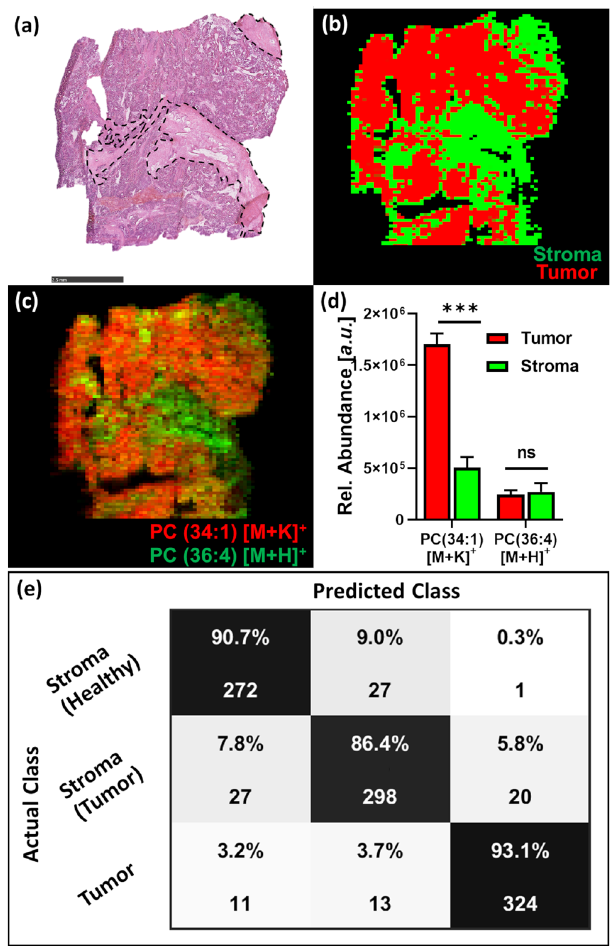
Figure 5. ( a ) Post-DESI-MSI H&E-stained tissue section of the ovarian tumor sample, scale bar = 2.5 mm. ( b ) MMC segmentation into tumor (red) and stroma (green), unclassified pixels are displayed as background (black). ( c ) Combined ion images for PC(34:1) and PC(36:4), and ( d ) relative abundances for these lipids in tumor and stroma tissue. ( e ) Ten-fold PLS random sub-set inter-sample cross-validation for 3 ovarian carcinoma samples and 2 healthy stroma samples. Bar charts represent the mean ± SD of annotated pixels. Statistical significance was determined via two-tailed, non-parametric test (Mann-Whitney); Significance level *** = p < 0.0001, ns = not significant.